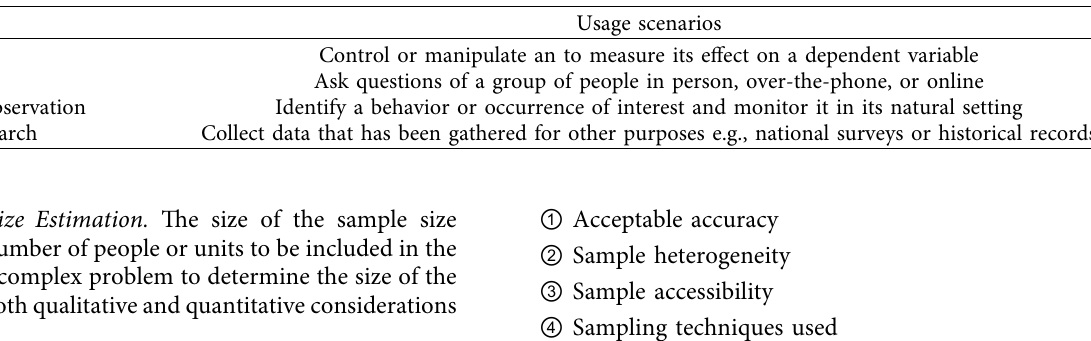
Table 4: Quantitative research data analysis